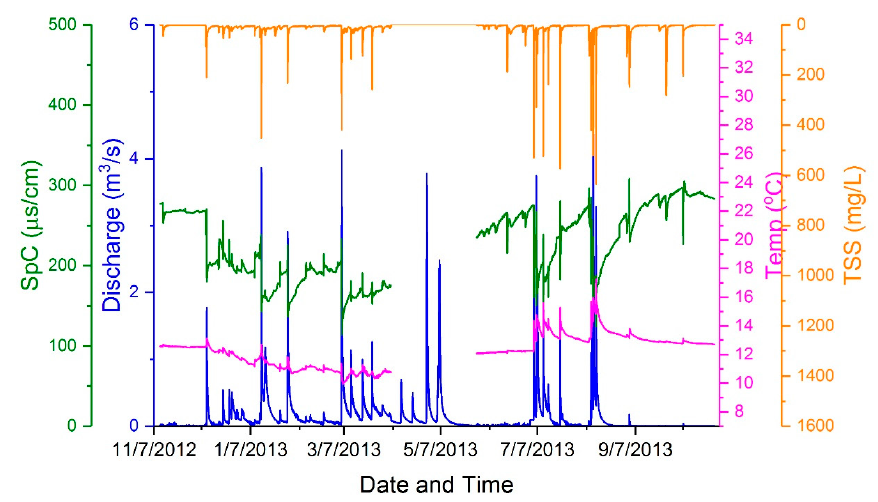
Figure 2. Time series data for Blowing Cave, Kentucky. Discharge record is continuous from November 2012 to October 2013. Water quality data include two continuous runs with a 7-week gap (TSS data is reversed for clarity).